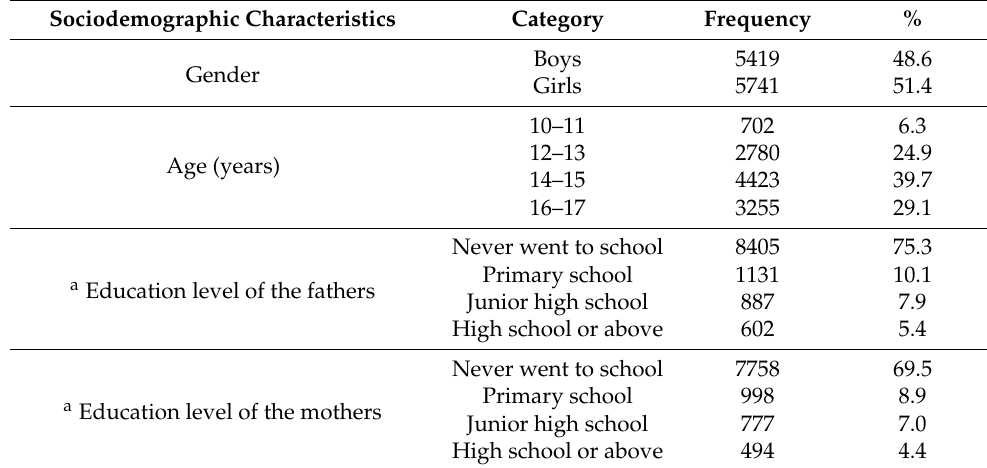
Table 1. Sociodemographic characteristics of the participants ( N =